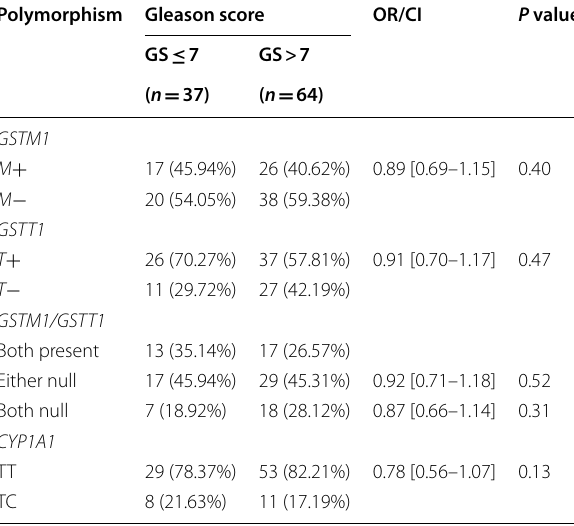
Table 4 Correlation between GSTM1, GSTT1, CYP1A1 genotypes and different Gleason scores Polymorphism Gleason score OR/CI